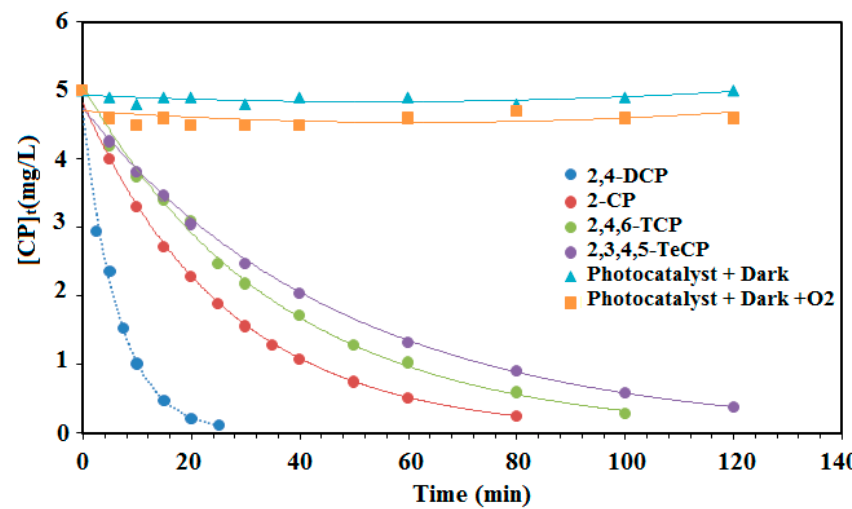
Figure 8. Effect of illumination times on the initial rates of separate photocatalytic degradation (r 0 ) of chlorophenols (2-CP, 2,4-DCP, 2,4,6-TCP and 2,3,4,5-TeCP). (The initial concentration of each phenol 5 mg/L, at pH = 8.)